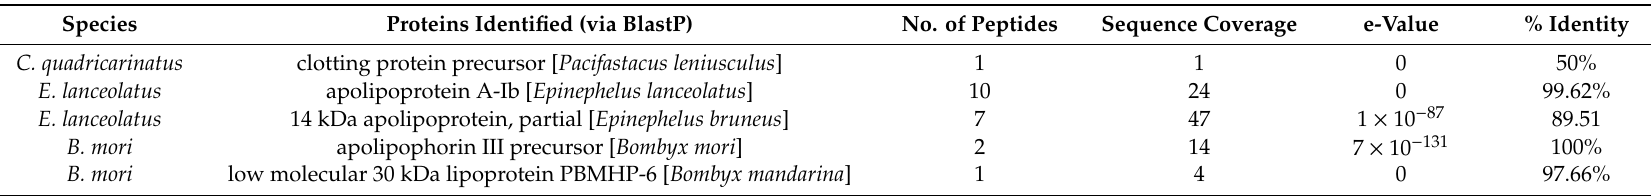
Table 1. Key proteins identified from mass spectrometry analysis. All proteins listed possess lipid binding or dsRNA binding capacity based on literature and domain analysis. Prior research has implicated lipid binding proteins in nucleic acid binding, so any identified proteins with this function or dsRNA binding potential were noted. Proteins were identified with NCBI BlastP, and data such as e-values and percent identities were recorded. Numbers of peptides and coverage from the mass spectrometer were noted as